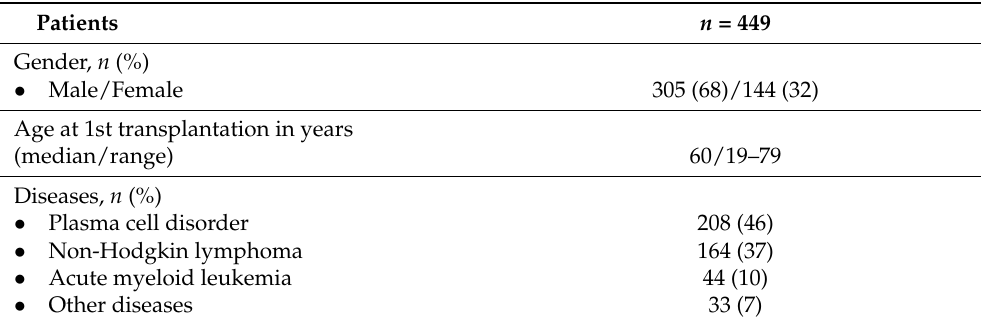
Figure 1. Flow chart of the patient cohorts and transplantations with or without AEs. Table 1. Characteristics of